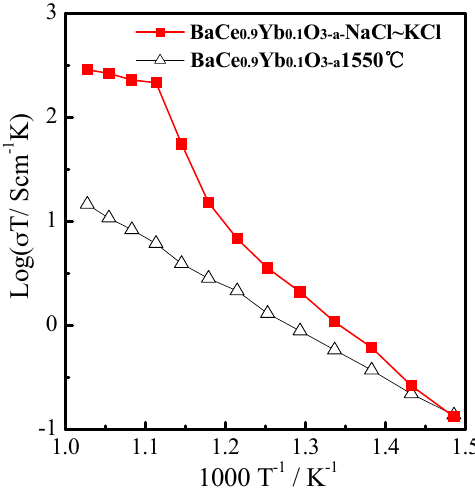
Figure 4. The log ( σ T) ~ 1000 T − 1 plots of BaCe 0.9 Yb 0.1 O 3 −α (1550 °C) and BaCe 0.9 Yb 0.1 O 3 −α -NaCl~KCl in the air from 400 °C to 700 °C.